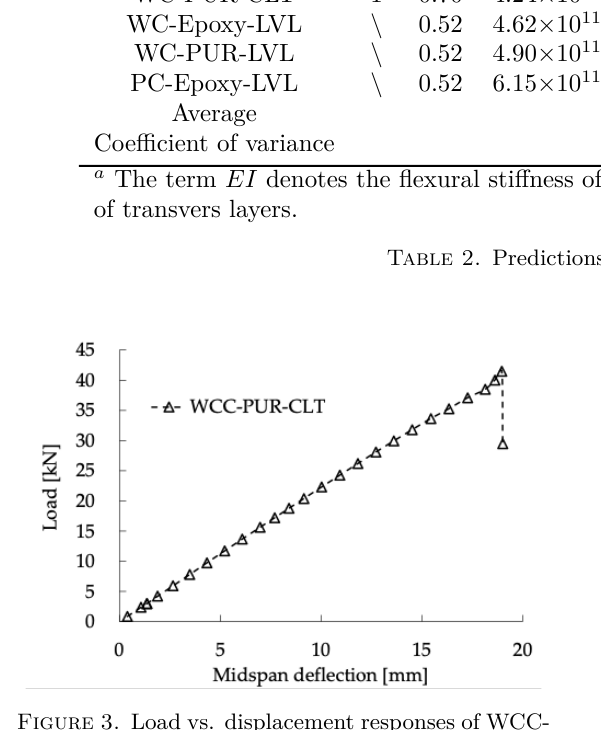
Figure 3. Load vs. displacement responses of WCC- PUR-CLT at